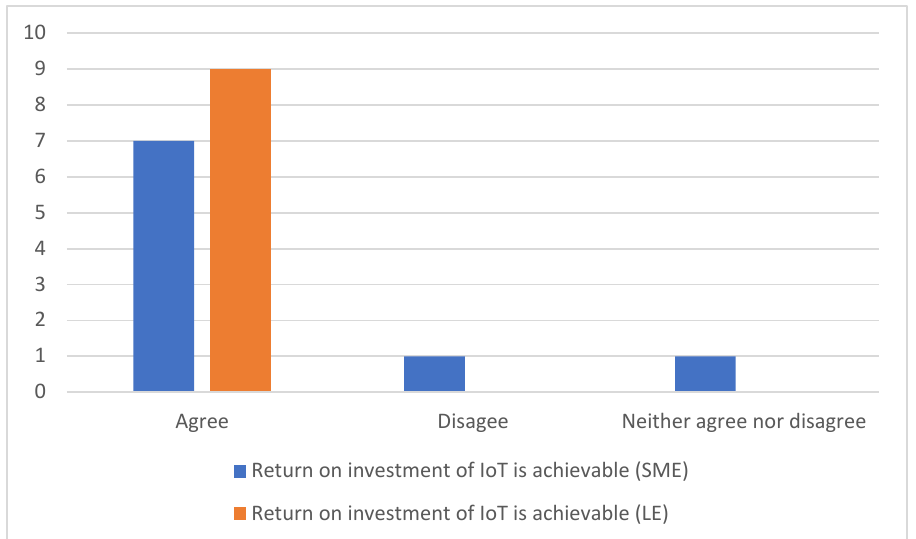
Figure 5. Participants’ response on return on investment related to IoT systems for SMEs and Les.